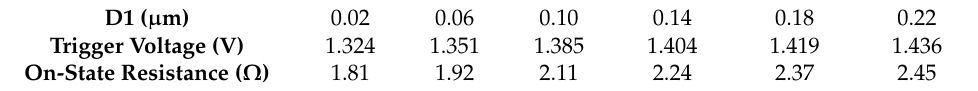
Figure 5. I ‐ V curves for SCR ‐ D in TCAD simulation with different D1 values. Table 3. Comparison of the key parameters of SCR ‐ D with different D1 values.